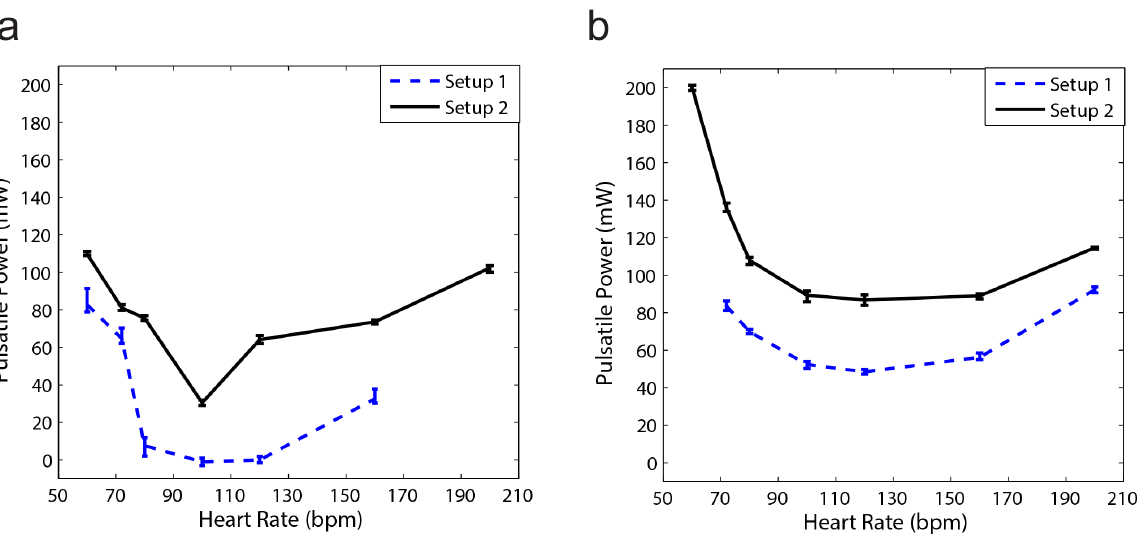
Figure 7. The effect of total volume compliance and total resistance on optimum HR . a) Pulsatile power versus HR for the aorta M3 with PWV=9.5 m/s . b) Pulsatile power versus HR for the aorta M 5 with PWV=13 m/s . Changing total resistance and total compliance affect mean, pulse pressure, and pulsatile power; however, they do not alter the optimum HR (optimum wave condition). Each power data point is the result of the respective experiment repeated five